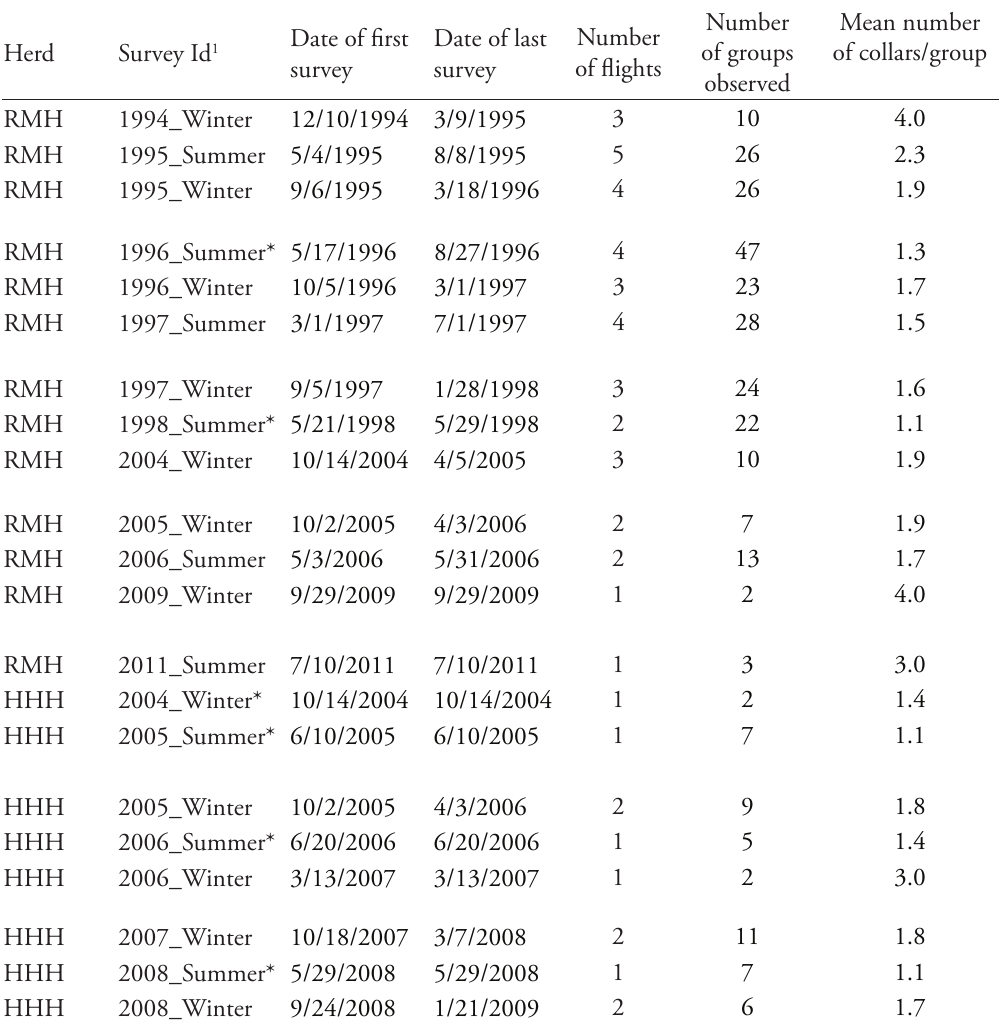
Table 1. Survey characteristics used to estimate abundance for the RMH and HHH in central Alaska.